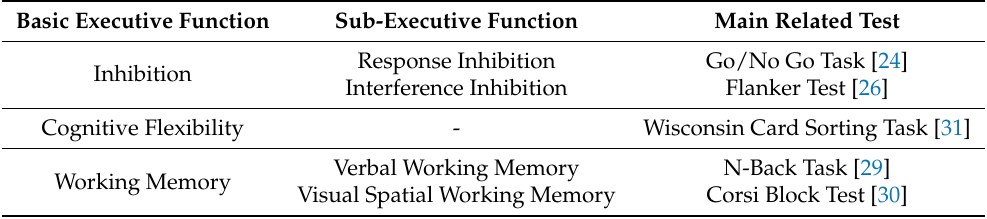
Table 1. FE investigated mainly in children with ADHD and the main tests for their analysis. Basic Executive